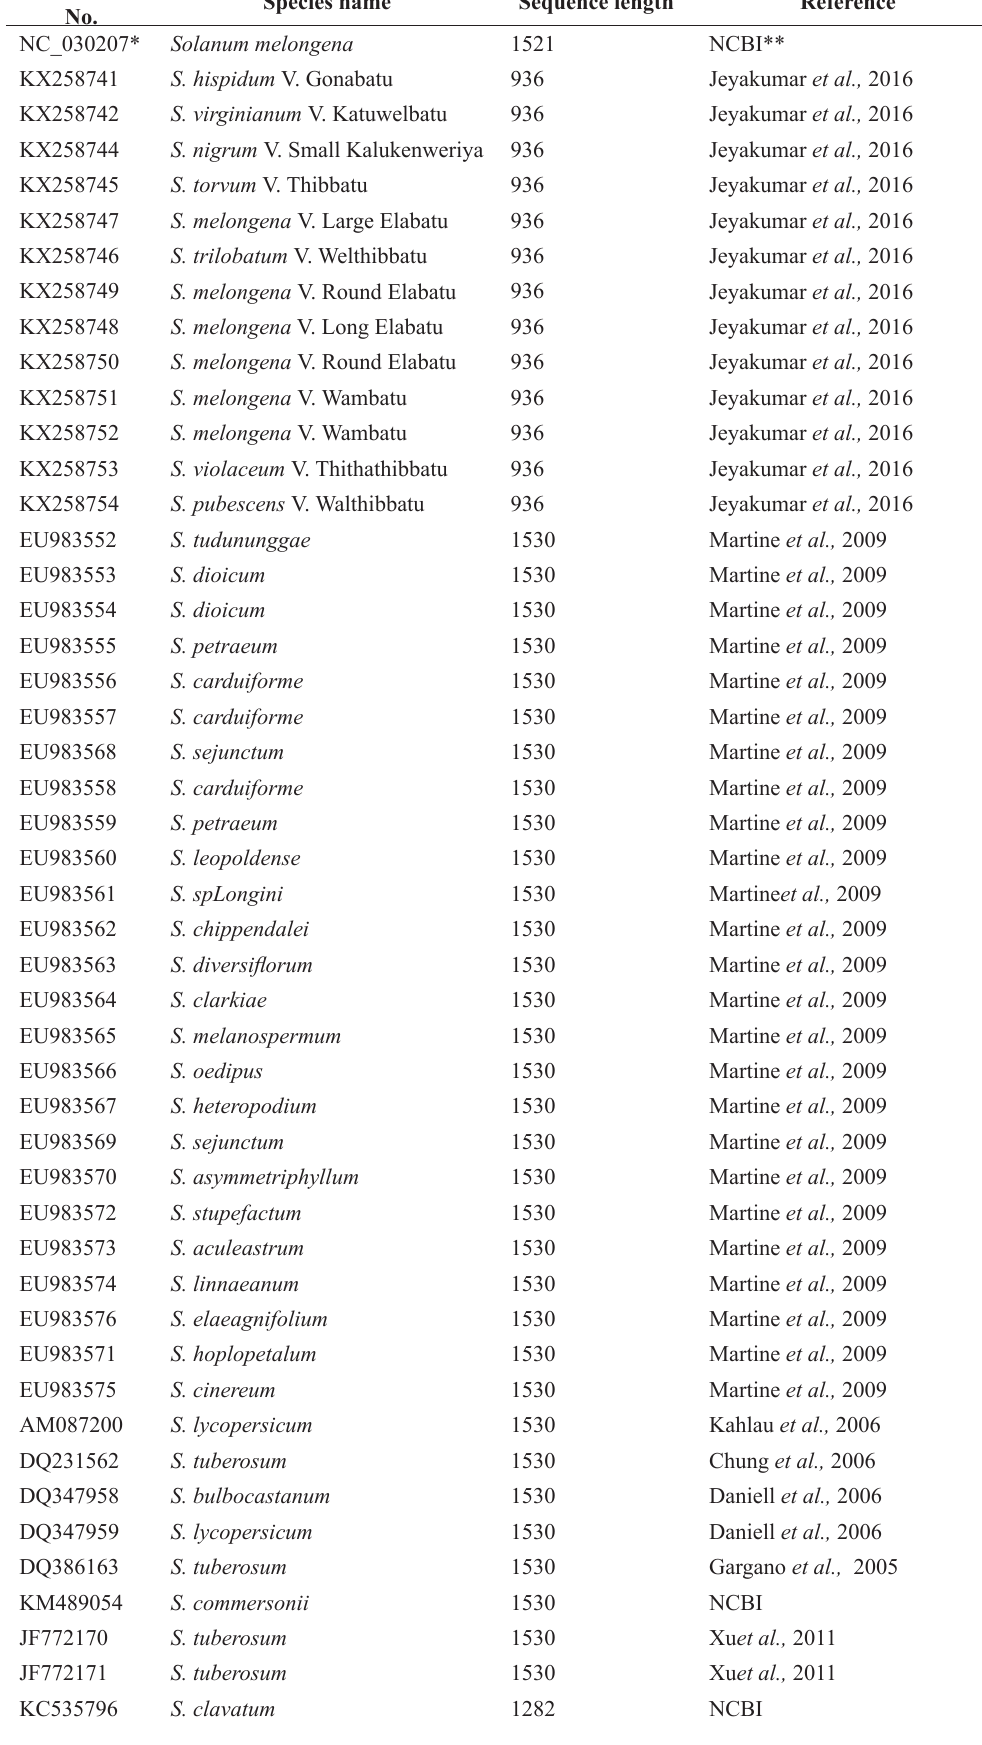
Table 1: The matk sequence data used in this study. Accession